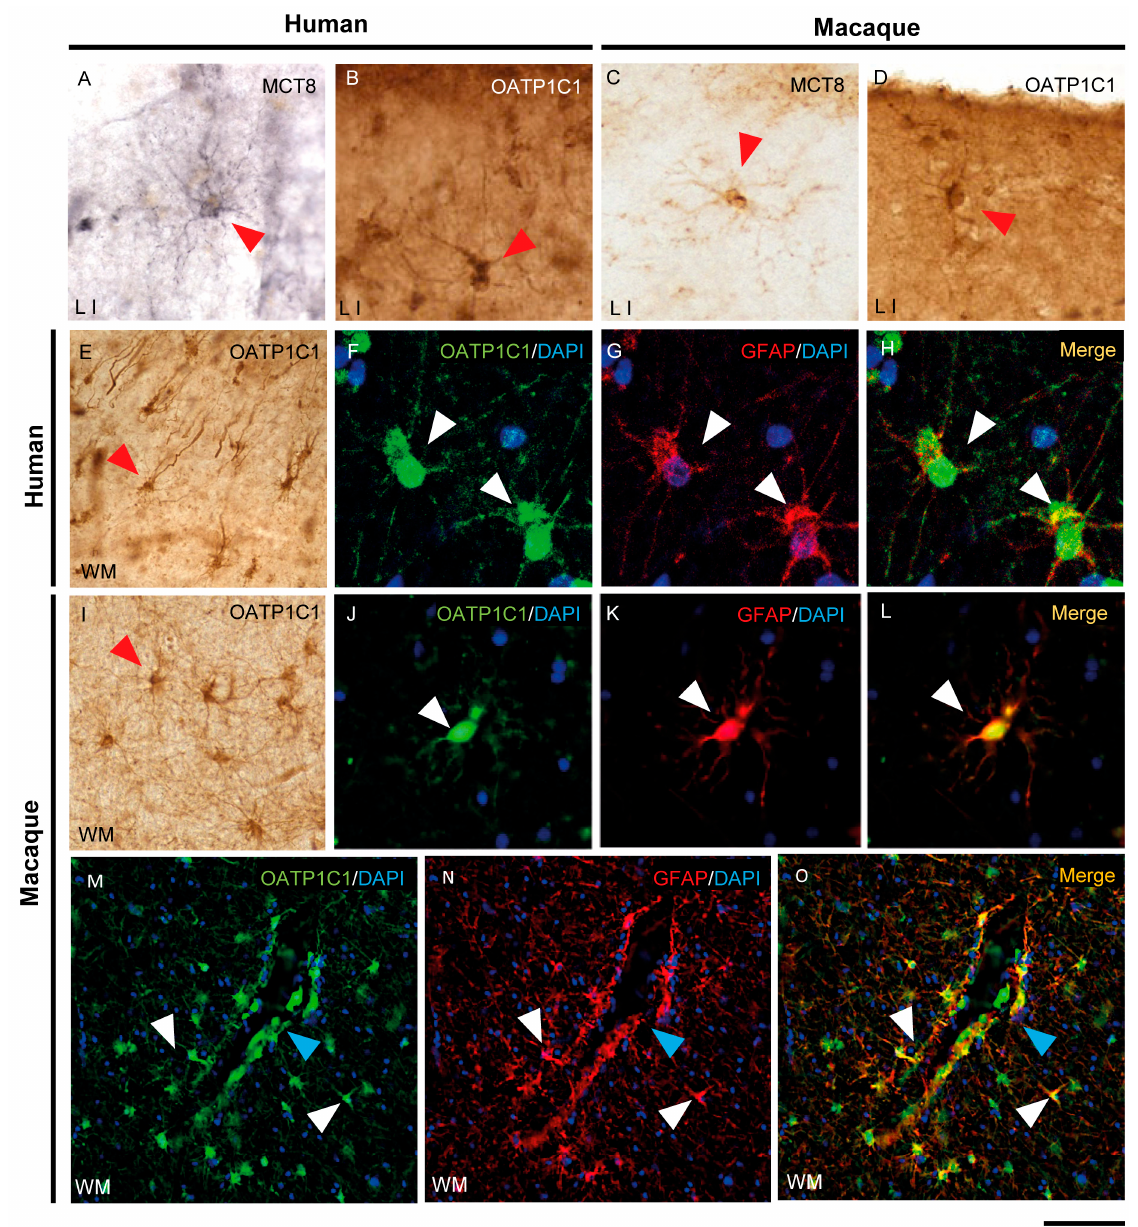
Figure 7. Expression of MCT8 and OATP1C1 in human and macaque motor cortex astrocytes. Representative brightfield ( A – E , I ) photomicrographs of sections immunostained for MCT8 ( A,C ) and OATP1C1 ( B,D,E,I ) in cortical layer I ( A – D ) and subjacent white matter ( E , I ). Confocal microscope images of human ( F – H ) and macaque ( J – O ) sections double-labeled for OATP1C1 (green) and GFAP (red). Counterstaining with DAPI (blue) shows nuclei of all cells. Note that there is full colocalization of both markers. White and red arrowheads point to astrocytes. Blue arrowheads point to a blood vessel. GFAP: glial fibrillary acidic protein. Scale bar = 50 μ m ( A – D , J – L ), 110 μ m ( E , I ), 25 μ m ( F – H ), and 78 μ m ( M – O ).